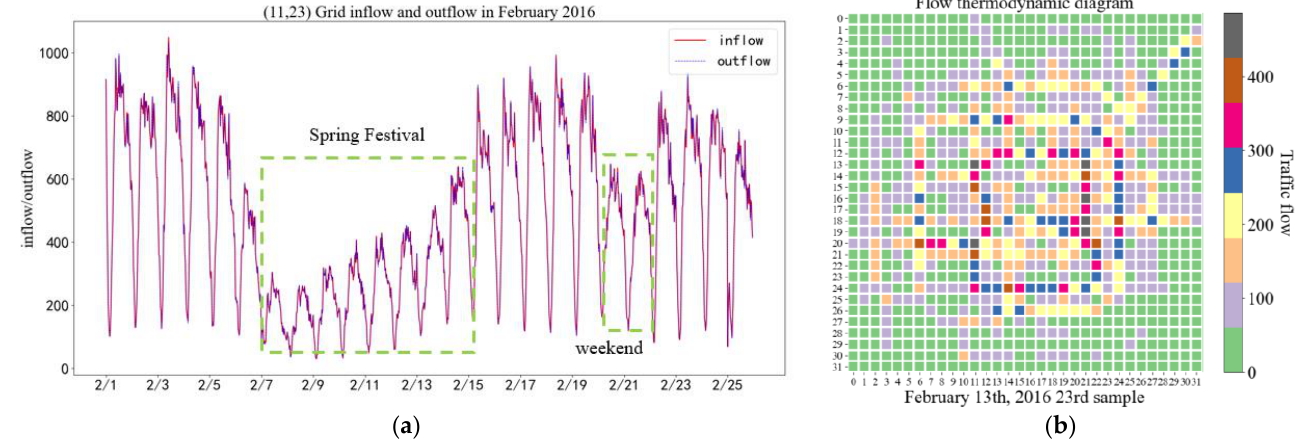
Figure 7. ( a ) Visualization inflow and outflow in February 2016; ( b ) flow heatmap on 13 February